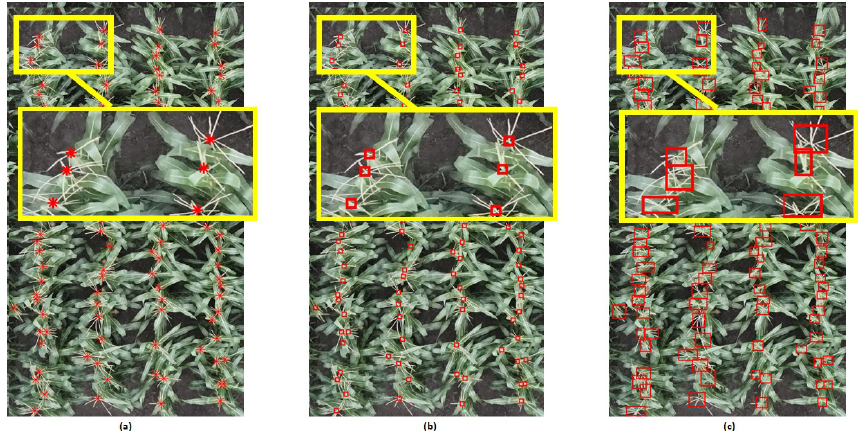
Figure 2. Tassel annotation: ( a ) Point; ( b ) Bounding box; ( c ) Modified bounding